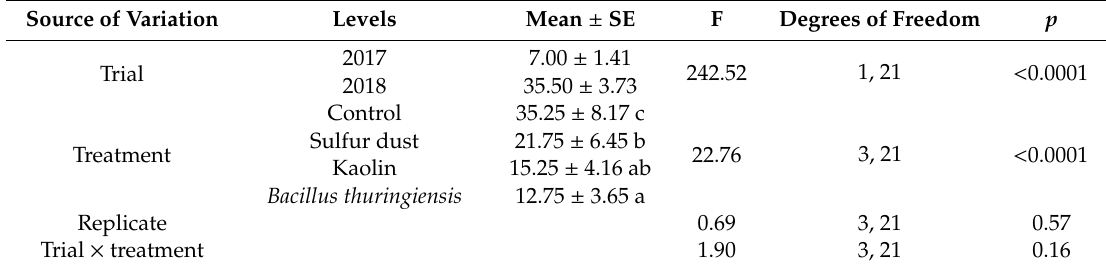
Table 2. Lobesia botrana third generation. Larval nests per 100 bunches recorded in the two field trials conducted in 2017 and 2018, respectively.